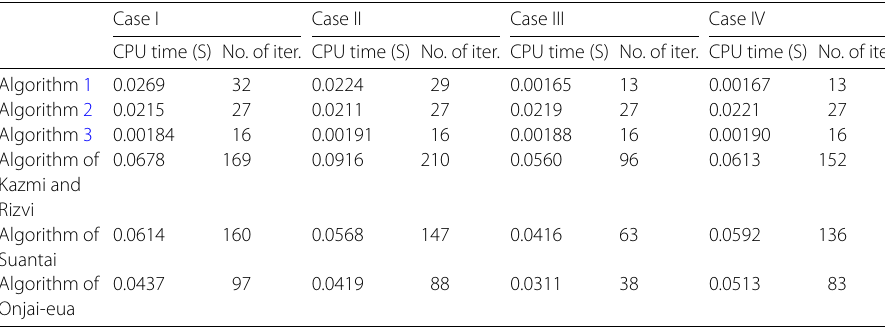
Table 2 Computational results for Example